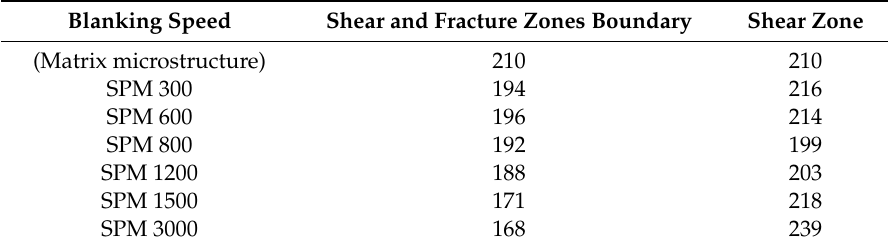
Table 1. The microhardness (HV) of the blanked edge at different blanking speeds. Blanking Speed Shear and Fracture Zones Boundary Shear Zone (Matrix